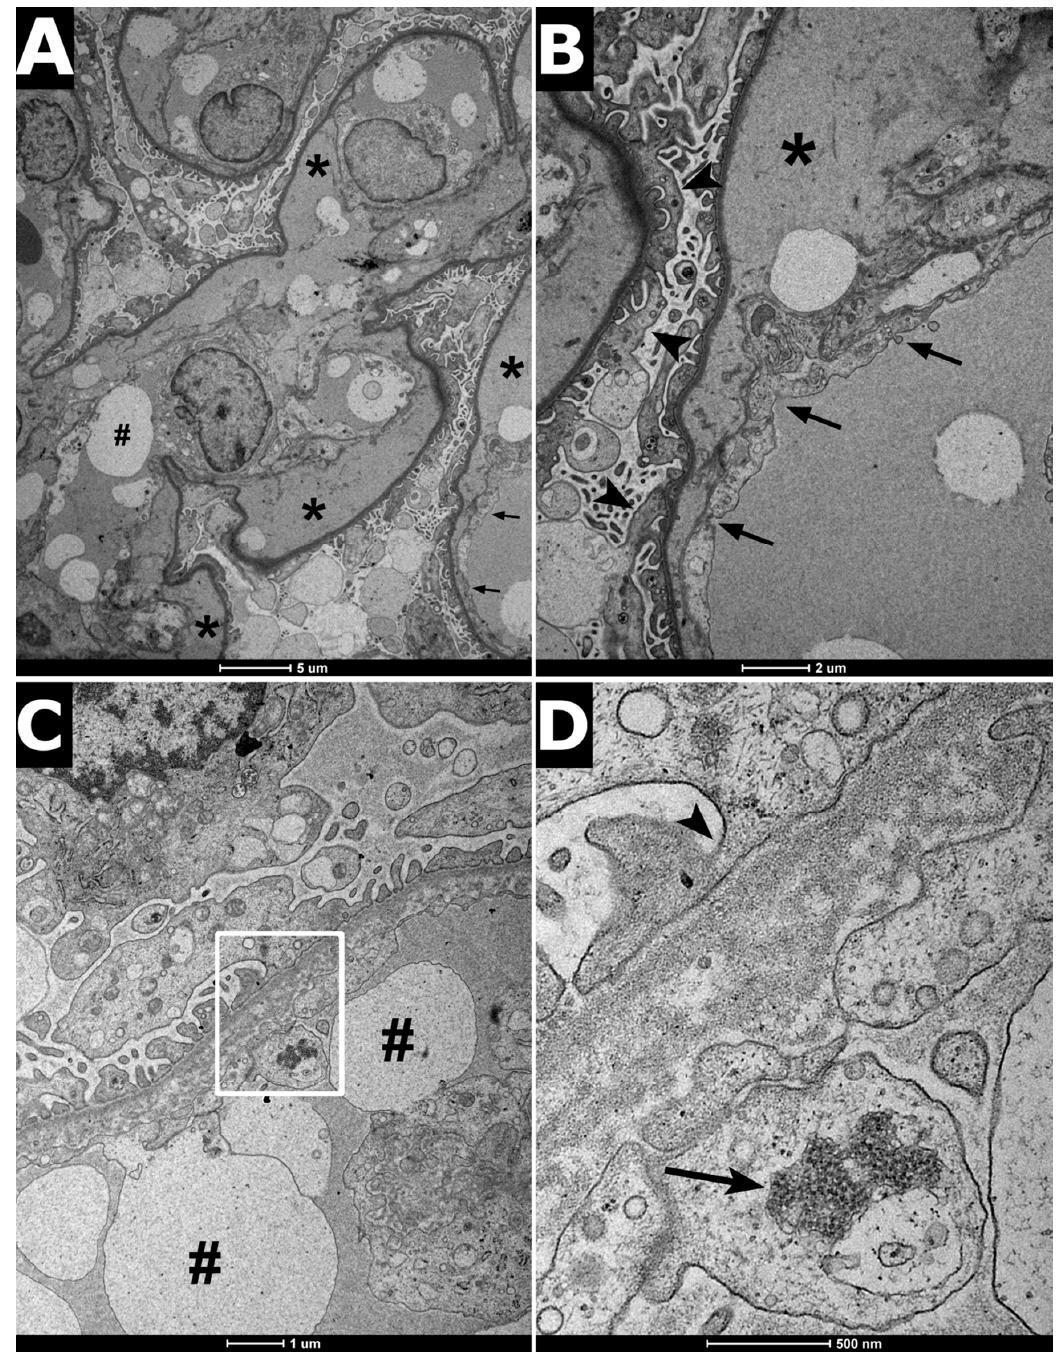
Figure 4. Electron microscopy findings in HUS. ( A ) Glomerular capillary separation of endothelial cells from the underlying glomerular capillary basement membrane (asterisks), markedly widened sub-endothelial space with fluffy-like material. Swelling of the capillary endothelial cells, electron lucent blebs are visible in the capilary lumen (#). Scale bar: 5 µm. ( B ) Higher magnification of a capillary wall; the arrows indicate the loss of endothelial fenestration, foot processes flattening, and microvilli on podocyte surface are also visible (arrowheads). Scale bar: 2 µm ( C ) Fragment of glomerular capillary wall with a widened sub-endothelial space and rich fluffy-like material under the endothelial cells. Capillary loop exhibits mild endothelial cell swelling with the absence of normal fenestra (#) Scale bar: 1 µm. ( D ) White box, magnification of ( C ) Endothelial cell contains a tubuloreticular inclusions (arrows). Moreover, flattening of podocyte foot processes also occurs (arrowhead). The presence of tubuloreticular inclusions (TRIs) in glomerular endothelial cells associated with viral infections (so-called interferon footprints) Scale bar: 500 nm..